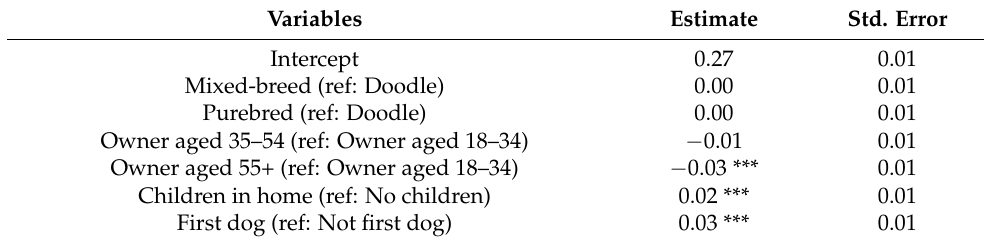
Table 5. The beta estimate and standard error for each factor in the general linear model examining the relationship between breed type, owner age, the presence of children in the home, whether this was the owner’s first dog, and owner perception of perceived costs of ownership. Variables Estimate Std. Error